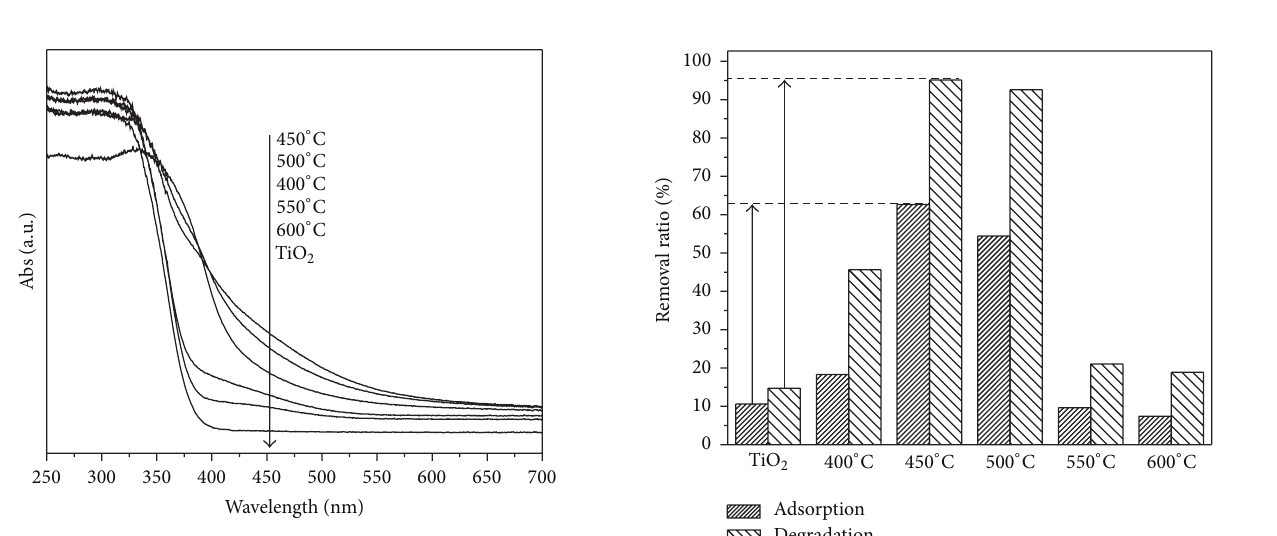
Figure 5: BET-BJH of the pure TiO 2 and C 3 N 4 coated TiO 2 nanocomposite obtained under 450 ∘ C.